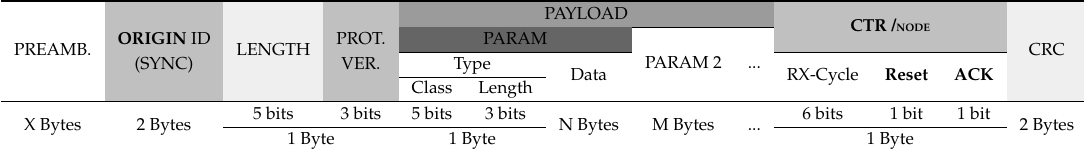
Table 2. treNch frame format for node-to-gateway transmissions (security Level 0).